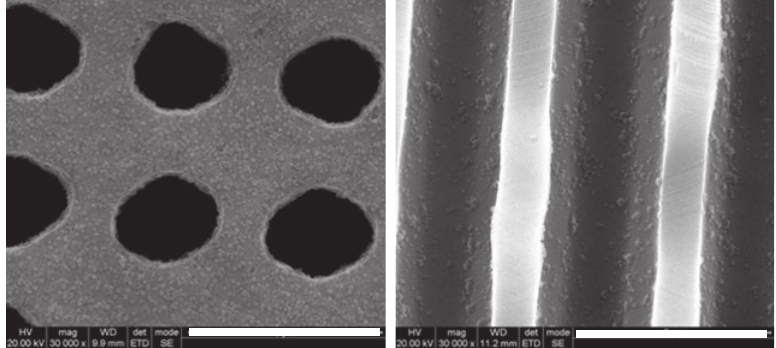
Figure 4 SEM images, ruler corresponds to 5 microns, of Si micromonoliths after coating with MFI seeds, top view and cross section.